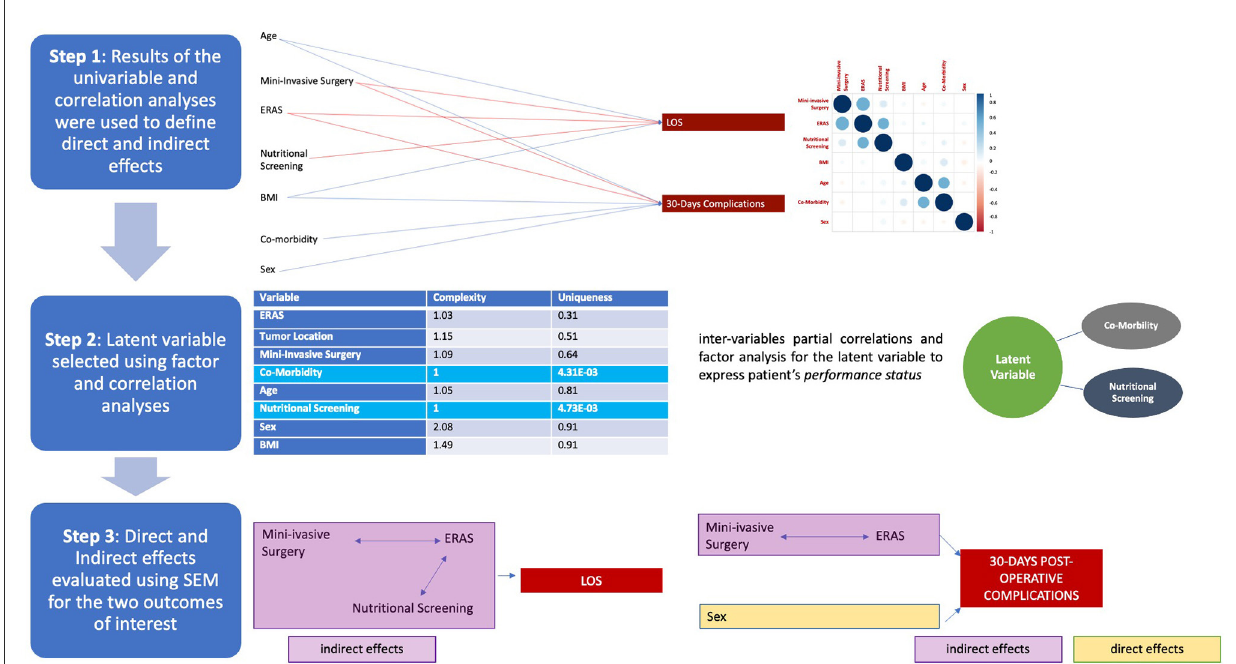
FIGURE3 Steps for structural equation modeling (SEM) analysis: the process is described starting from the top as illustrated in the process diagram depicted on the left side of the picture. Steps are presented in the same sequential order as the statistical analyses. First step: univariable analyses and partial correlations. In the first part, the results of statistical value reported in Table 1 are depicted, with the positive (blue) or negative (red) correlation of variables with the outcomes [i.e., increased age correlated with increased length of hospital stay (LOS), blue line; whereas the use of mini-invasive surgery negatively correlated with the same outcome, red line]; the correlation diagram is the same as presented in Figure 2. Second step: definition of the latent variable according to factor analysis and based on those variables presenting greater uniqueness criteria: comorbidity and nutritional screening. Third step: finally, the final stage is depicted at the bottom of the figure (the definition of direct–yellow and indirect–pink effects on the outcomes).